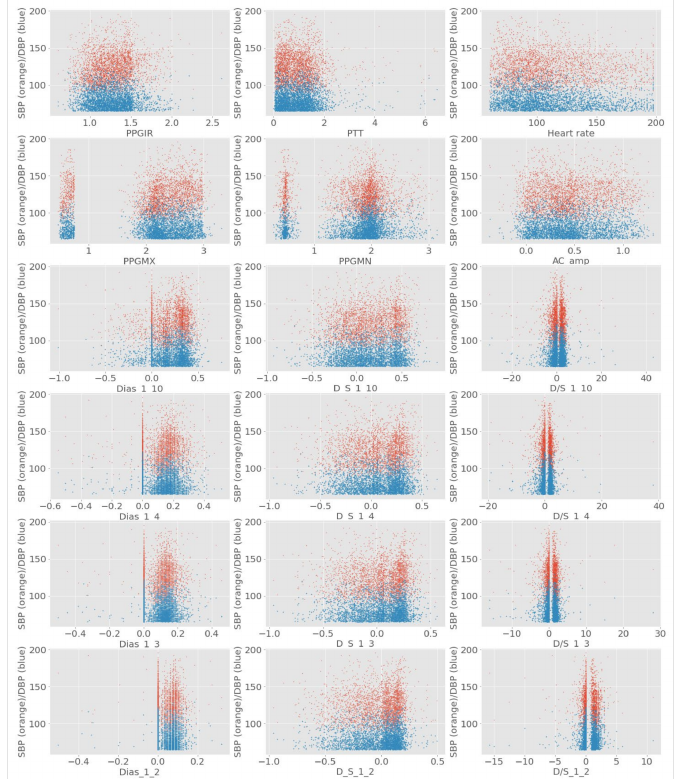
Figure 13. The distribution of SBP and DBP against some of the extracted